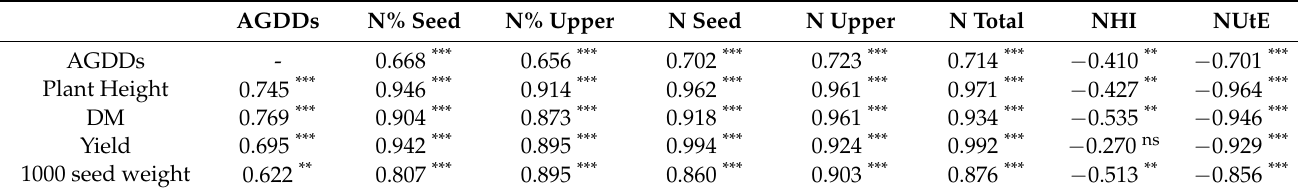
Table 3. Correlation matrix among AGDDs, seed traits, yield, agronomic features of flax, and N indicies. AGDDs N%